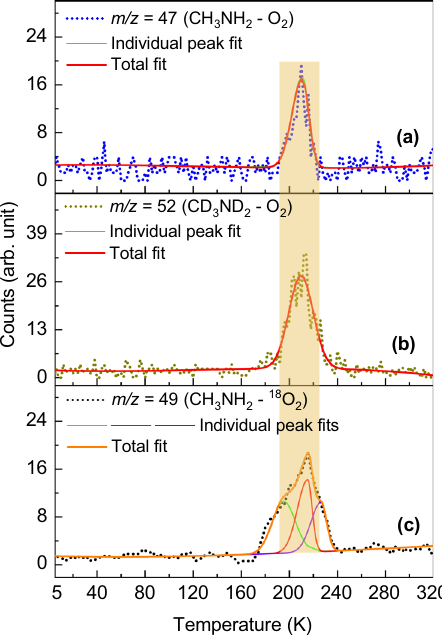
Fig. 4 PI-ReTOF mass spectra collected at m/z = 47 as a function of temperature. a Measured at 9.50 eV photon energy during the sublimation phase of irradiated methylamine-oxygen ices. b Recorded at 9.10 and 10.49 eV photon energies during the sublimation phase of irradiated and non-irradiated ice mixtures, respectively. Source data are provided as a Source Data fi le.